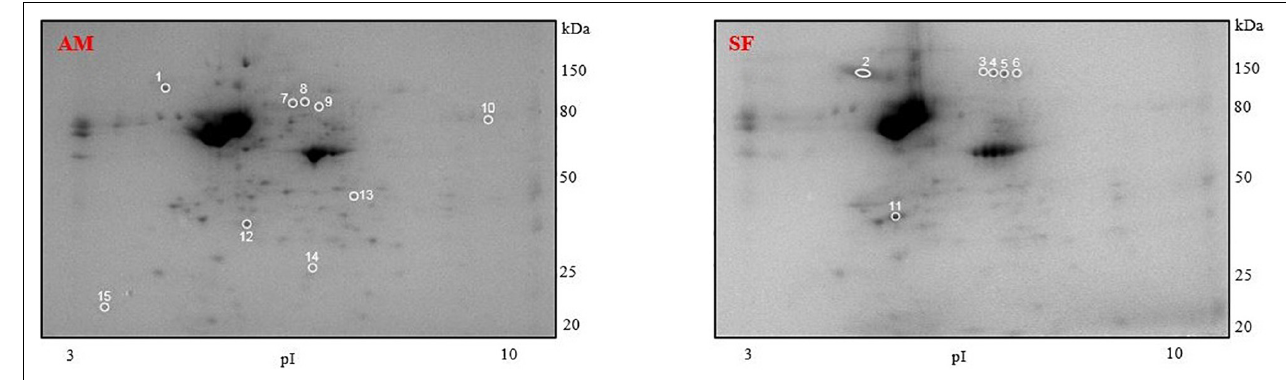
FIGURE 7 | Representative protein profiles of L. lota spermatozoa after dilution in AM and SF. Each specimen was analyzed five times by two-dimensional gel electrophoresis. Circles show differentially expressed protein spots. Molecular weight marker is on the right. pI, isoelectric points.